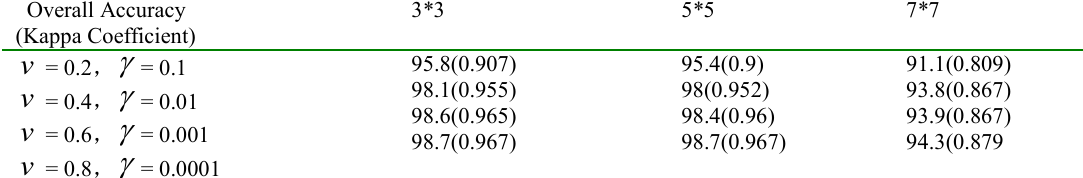
Table 3 Change detection results with blocks of different sizes